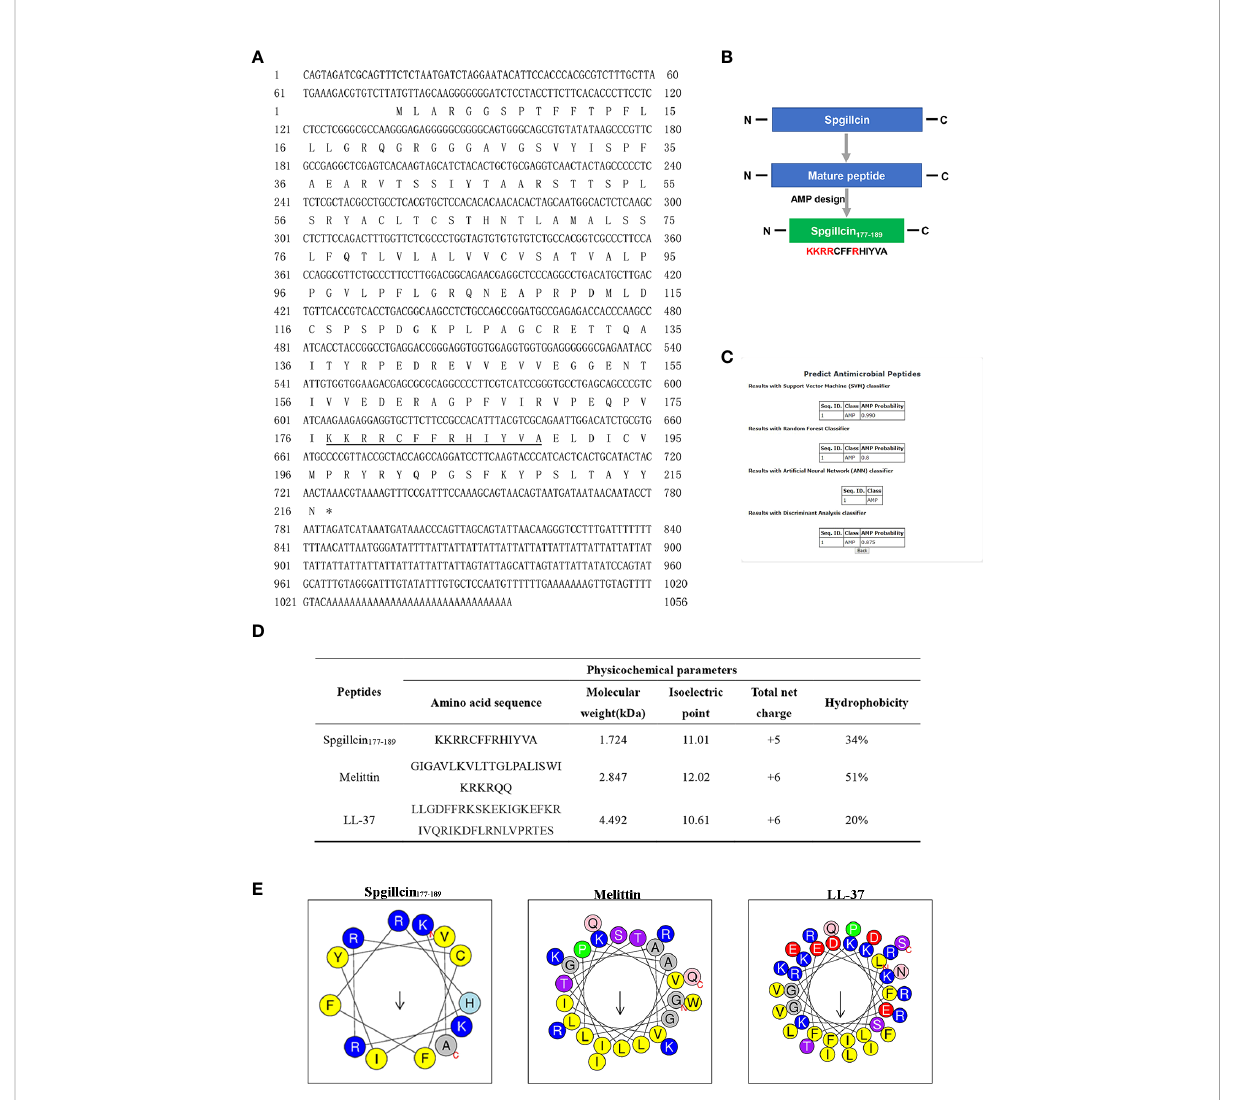
FIGURE 1 Sequence information and truncated peptide analysis. (A) Full-length cDNA and the deduced amino acid sequences of Spgillcin. The cDNA sequence had been deposited in Genbank, and the accession number was MZ131629. The underlined regions represent the amino acid sequence of Spgillcin 177 – 189 . (B) The design process of the truncated peptide and the cationic residues are marked in red. (C) The probability of